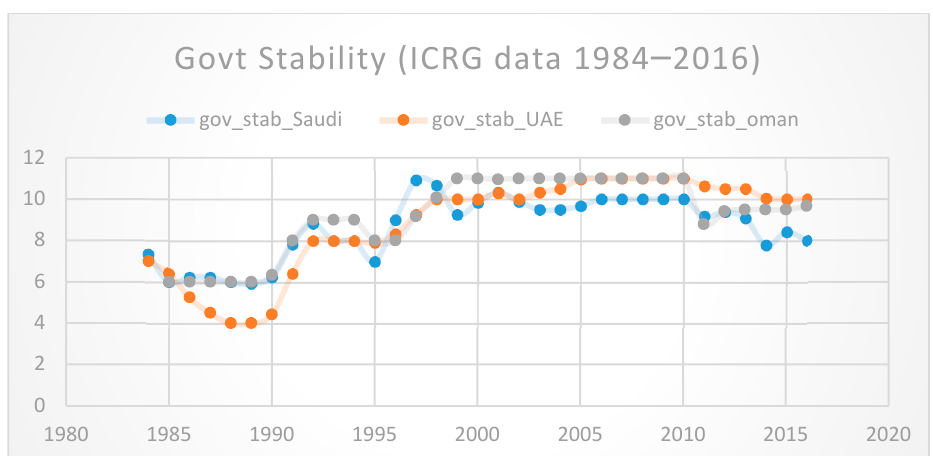
Figure 2. Law and Order.